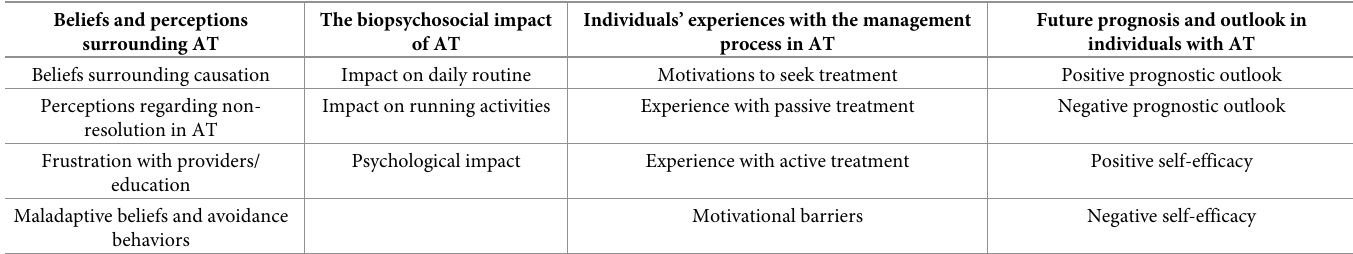
Table 3. Identified main themes and sub-themes. Beliefs and perceptions surrounding